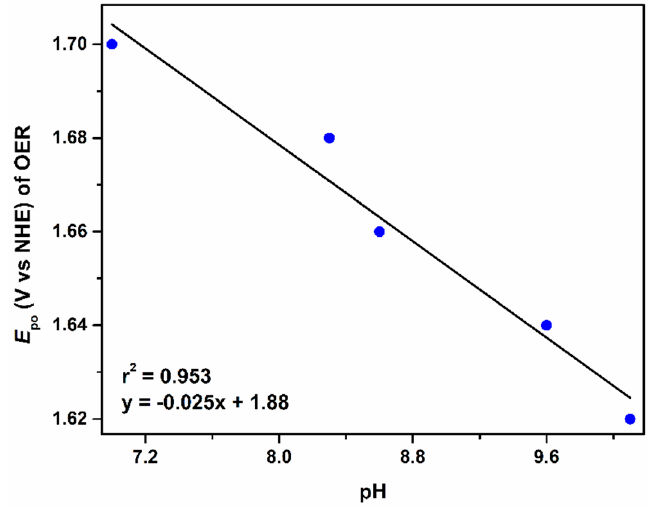
Figure 4. A plot of the water oxidation peak/plateau potential vs. the pH of the medium. The voltammograms are recorded in 1.0 mM Na 3 [Ru 2 ( µ -CO 3 ) 4 ] and 0.20 M NaClO 4 aqueous solutions at different pHs with a scan rate of 50 mV·s − 1 under N 2 atmosphere.